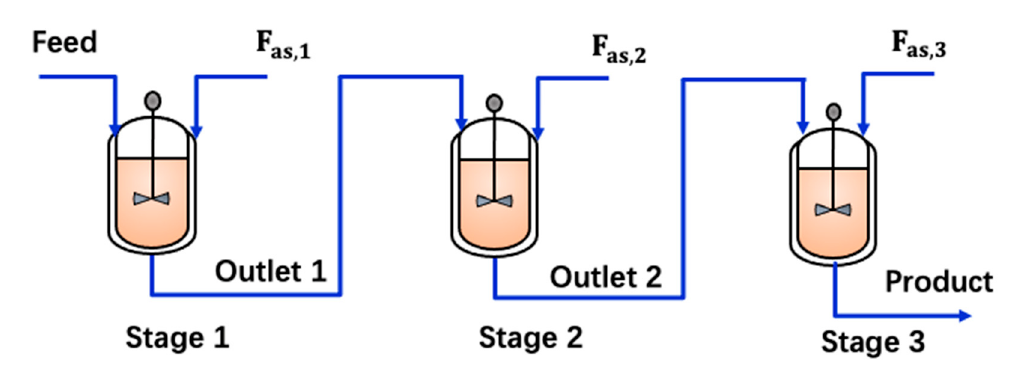
Figure 1. Cascade of three MSMPR